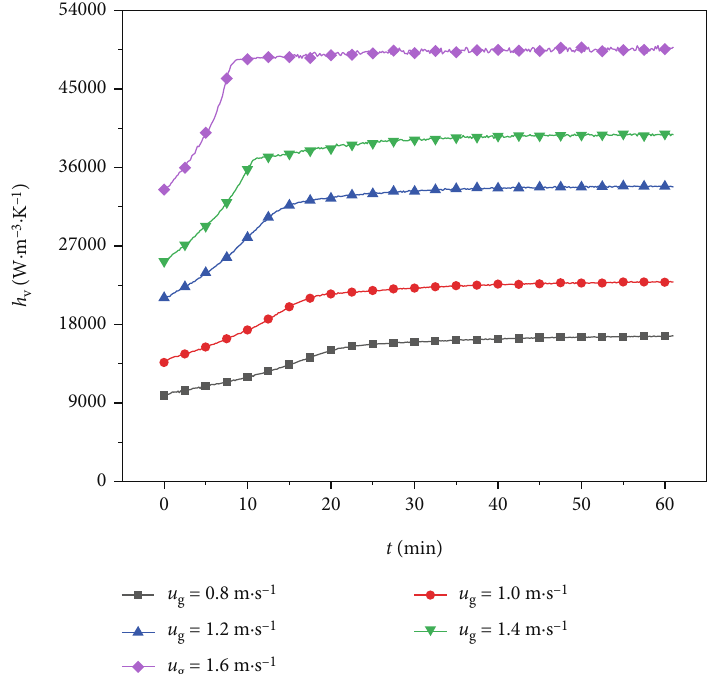
Figure 14: Variation of the heat transfer coe ffi cient h